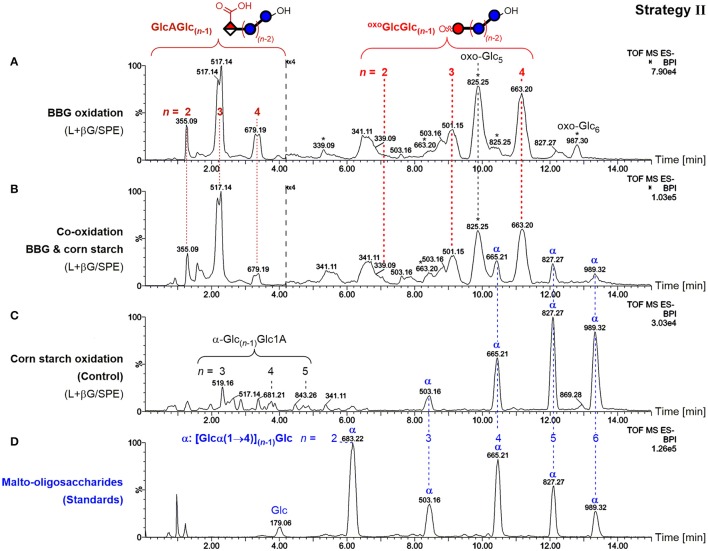
Comparison of UPLC-MS base-peak ion (BPI) chromatograms of polysaccharide oxidation under harsh conditions (100 mM H2O2, 50 μM FeSO4) after lichenase and β-glucosidase treatment/SPE for (A) only barley β-glucan (BBG) (0.6%; as in Figure 5A), (B) BBG and corn starch (each 0.6%), and (C) only corn starch (0.6%). (D) UPLC-MS of malto-oligosaccharide standards up to maltohexaose (n = 6). Glc, glucose; Glc1A, gluconic acid; GlcA, glucuronic acid; oxoGlc, oxo-glucose; oxo-Glcn, gluco-oligomer with oxidized carbonyl group anywhere along the chain; oxoGlcGlc(n−1), gluco-oligomer with oxidized carbonyl at non-reducing end; L+βG/SPE, after lichenase and β-glucosidase treatment, followed by fractionation by SPE; *, oxo-Glcn with oxidized C=O not at the non-reducing end; α, malto-oligosaccharides [Glcn with all α-(1→4)].